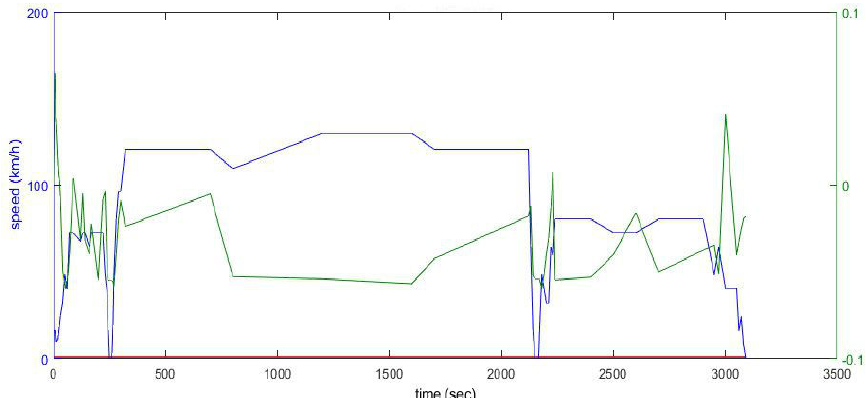
18 of 36 Figure 4. Speed profile of WVUCITY cycle. Table 15. WVUCITY cycle. WVUCITY Cycle Time